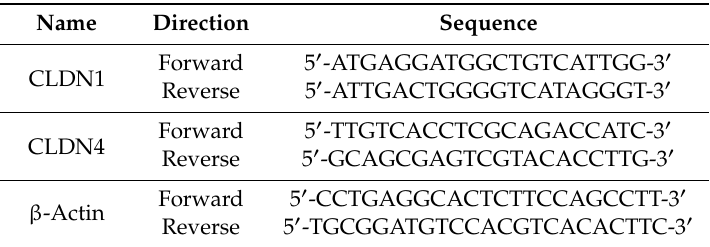
Table 1. Primer pairs for real-time PCR.